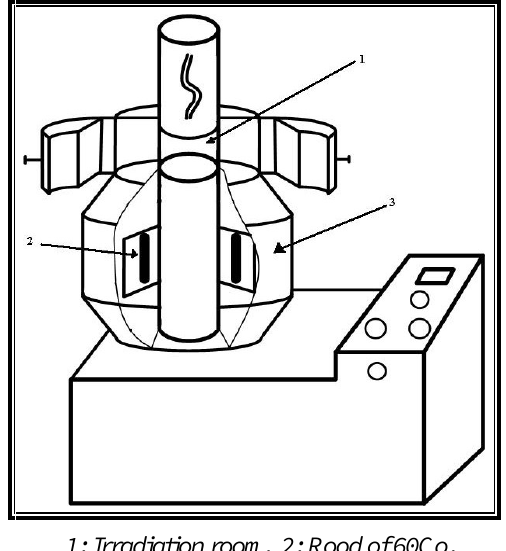
Figure 1: Gamma cell irradiation facility type 220 Canadian made